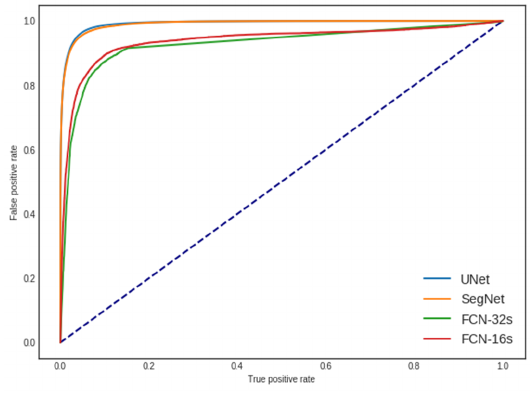
Figure 8. ROC curve per model.